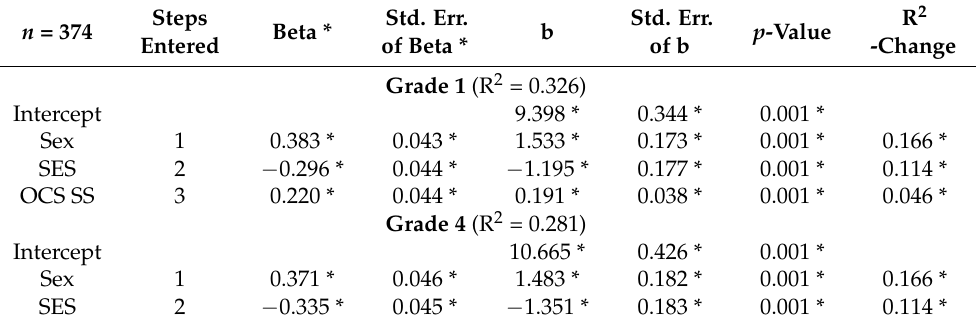
Table 4. A stepwise regression analysis of grade 1 and grade 4 OCS SS on grade 7 participants CAMSA skills score as adjusted for SES and